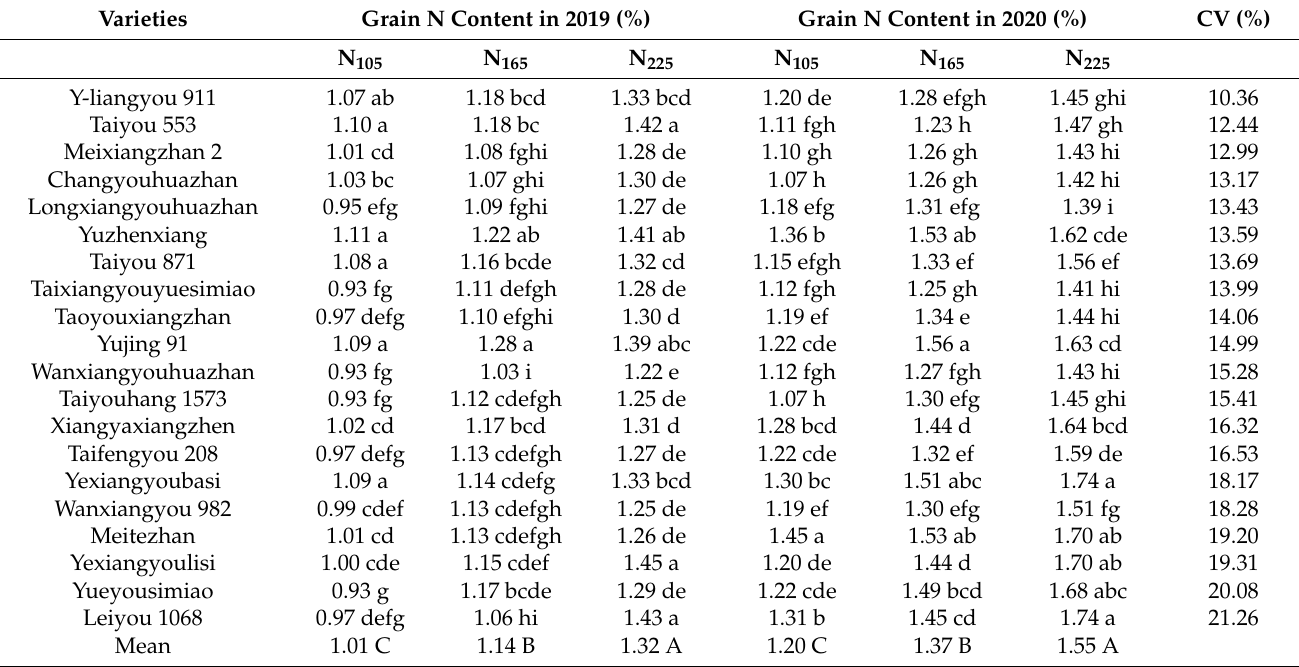
Table 2. Grain N content and its coefficient of variation (CV) of high-quality rice varieties under different N application